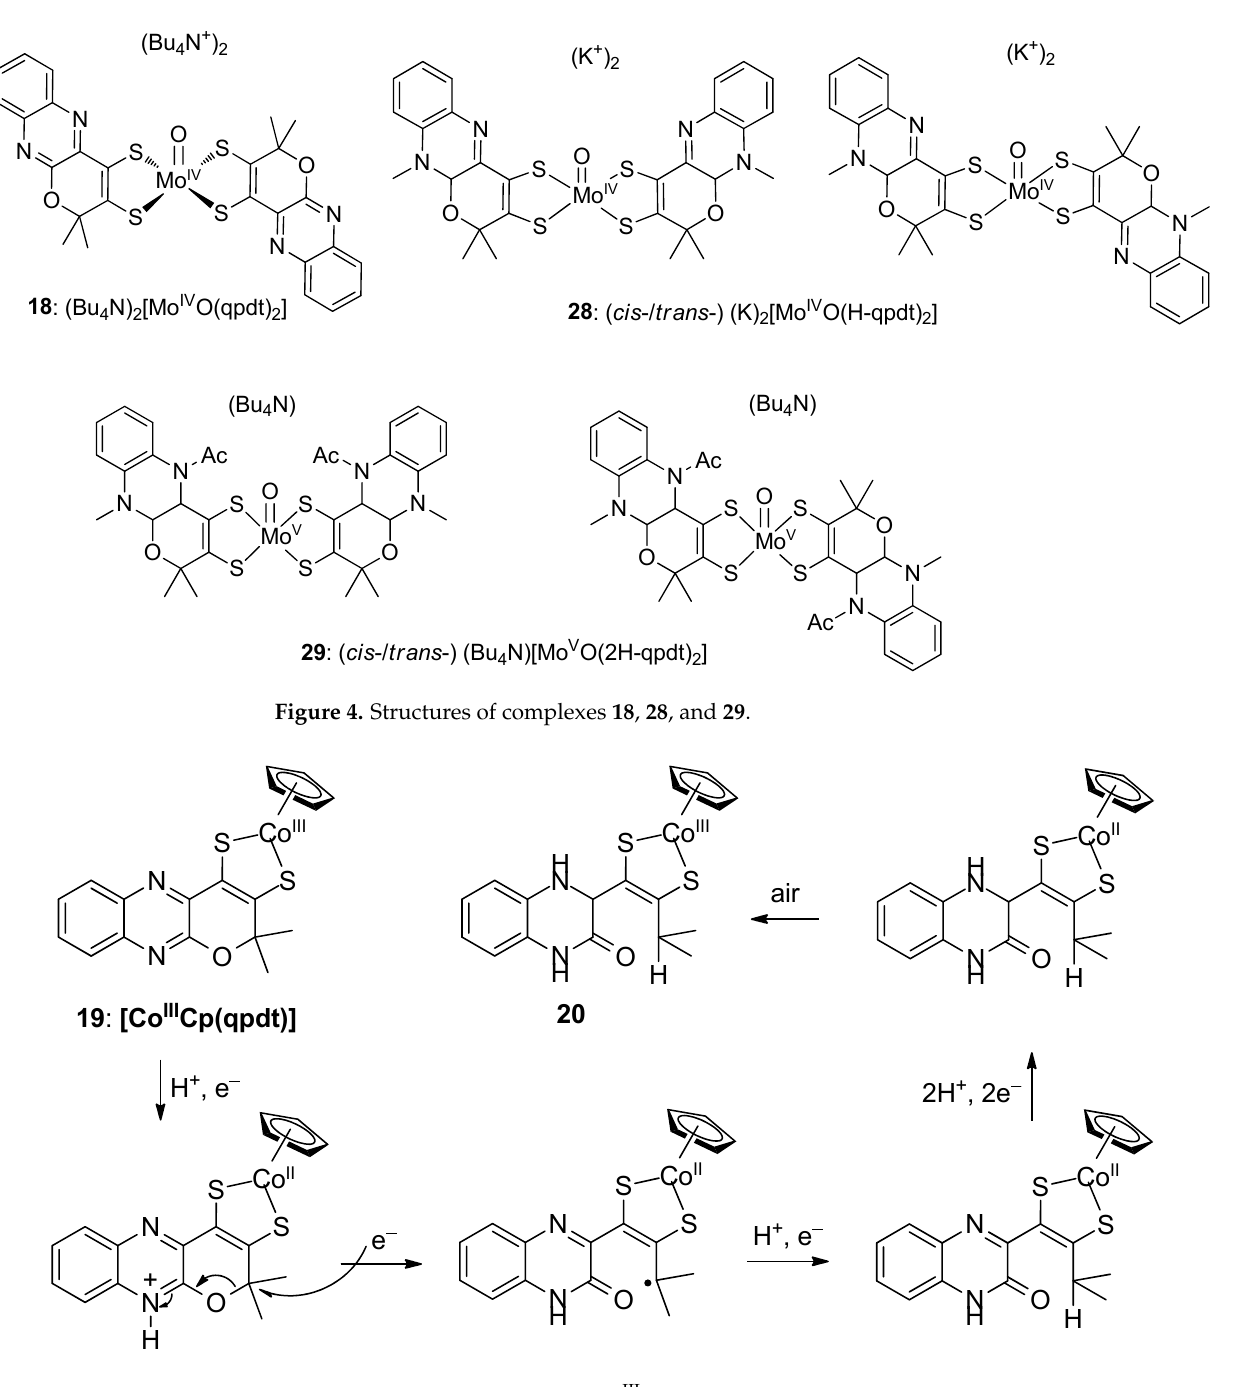
Scheme 8. Electro ‐ reduction of [Co III Cp(qpdt)] resulting in an unusual ring